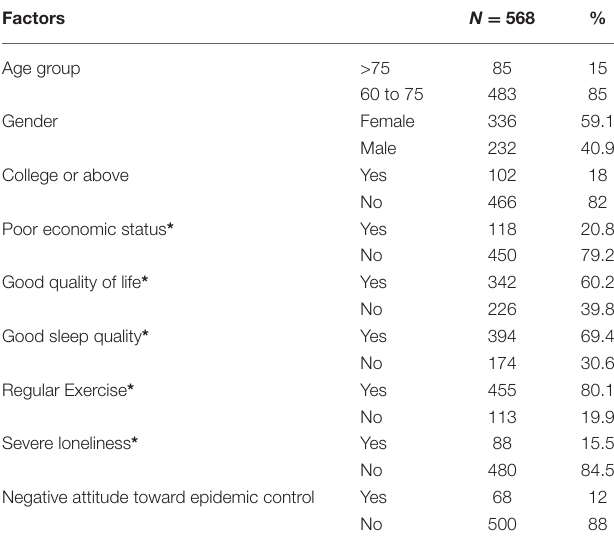
TABLE 1 | Demographic details of the study participants.